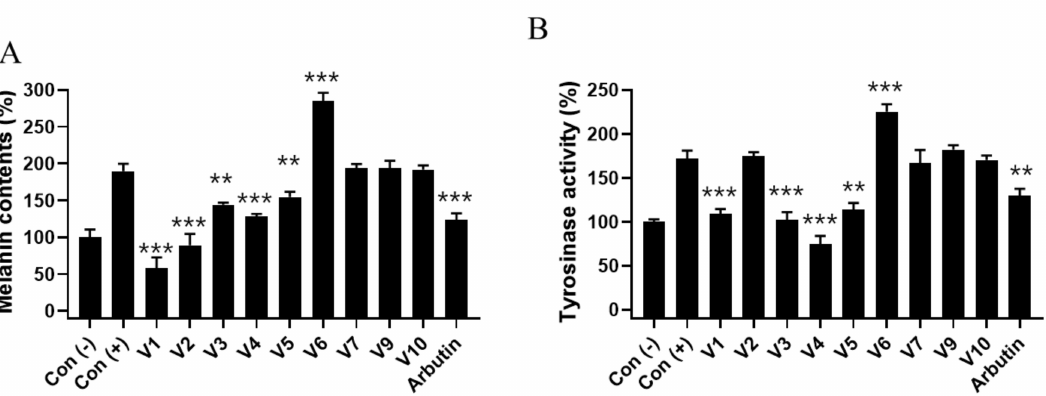
Figure 3. Effect of velutin derivatives on intracellular melanin synthesis in B16F10 melanoma cells. B16F10 cells were treated with 0.1% DMSO as vehicle, or with 10 µ M of each derivative, for 48 h. ( A ) Melanin content in the B16F10 cells was determined using a photometric method, as described in the Experimental Section. ( B ) Cellular tyrosinase activity was determined by measuring dopachrome generated by the enzymatic reaction of cell lysates with L -DOPA. Data are expressed as the mean ± SD of three independent experiments (** p < 0.005, *** p < 0.001 as compared to α -MSH-stimulated B16F10